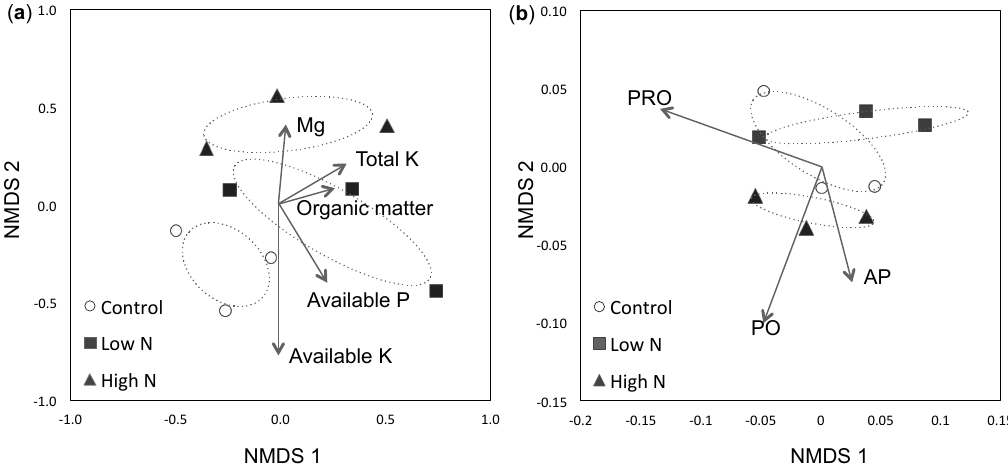
Figure 1. Non-metric multidimensional scaling (NMDS) ordination of ectomycorrhizal (ECM) fungal communities in control and N-fertilized plots based on: ( a ) the ECM root tip community, ( b ) the activity of extracellular enzymes. Each point represents the fungal community composition in each plot. Significant environmental variables are shown: P-phosphorus; K-potassium; Mg-magnesium.